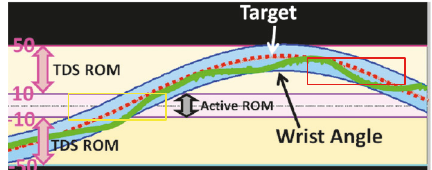
Figure 3: Example of visual feedback given to participants. Active ROM (pink zone) represents the magnitude of motion in which the participant is able to volitionally move her or his wrist. The Tongue Drive System (TDS) ROM, where tongue control can command the HM, is the portion of available ROM in which the stroke survivor is not able to voluntarily move. Vertical pink errors represent the TDS ROM above and below the stroke survivors active ROM. Highlighted yellow and red regions represent portions of tracking waveforms in which the stroke survivor will exclusively use the hand and the tongue and hand,